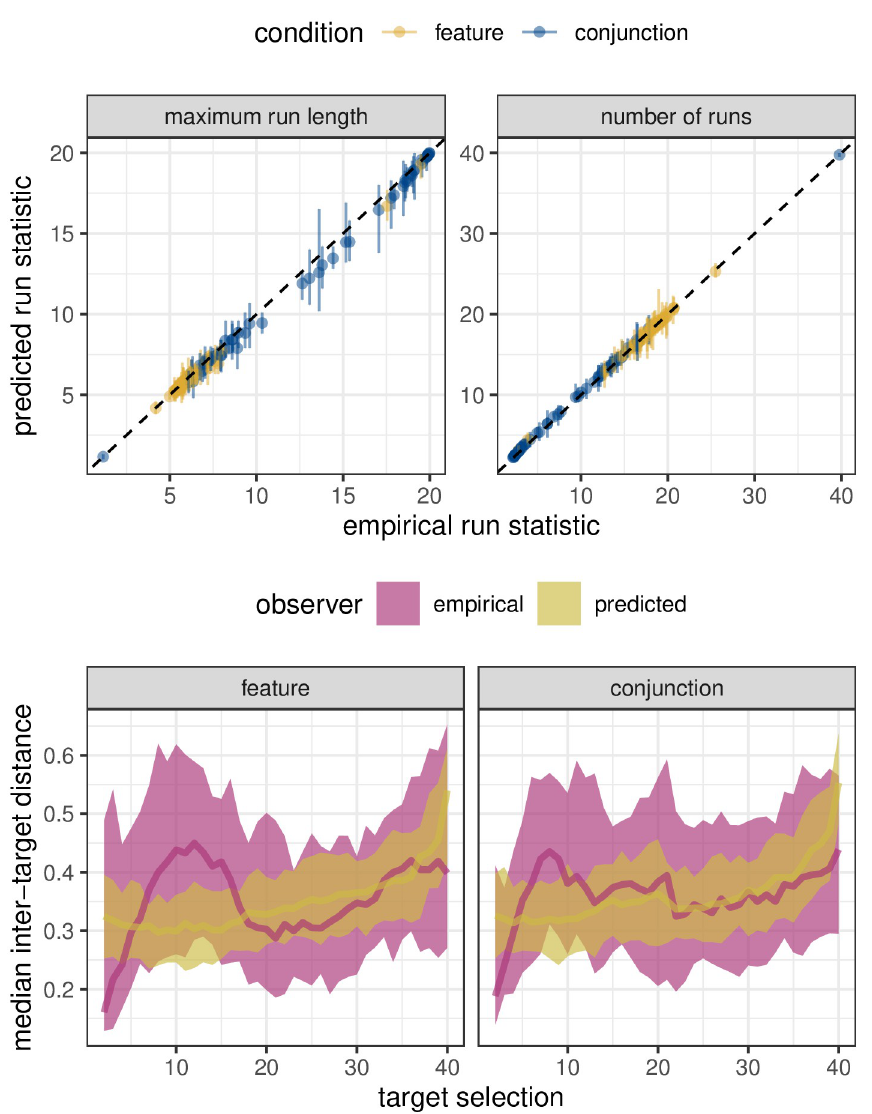
Fig 9. Posterior predictions for Clarke et al. (2018). ( top :) Scatter plots between empirical and predicted summary run statistics. Error bars indicated 89% HPDI for the posterior predictions. ( bottom :) Comparison of inter-target distances and how they vary over time. Shaded region gives 89%